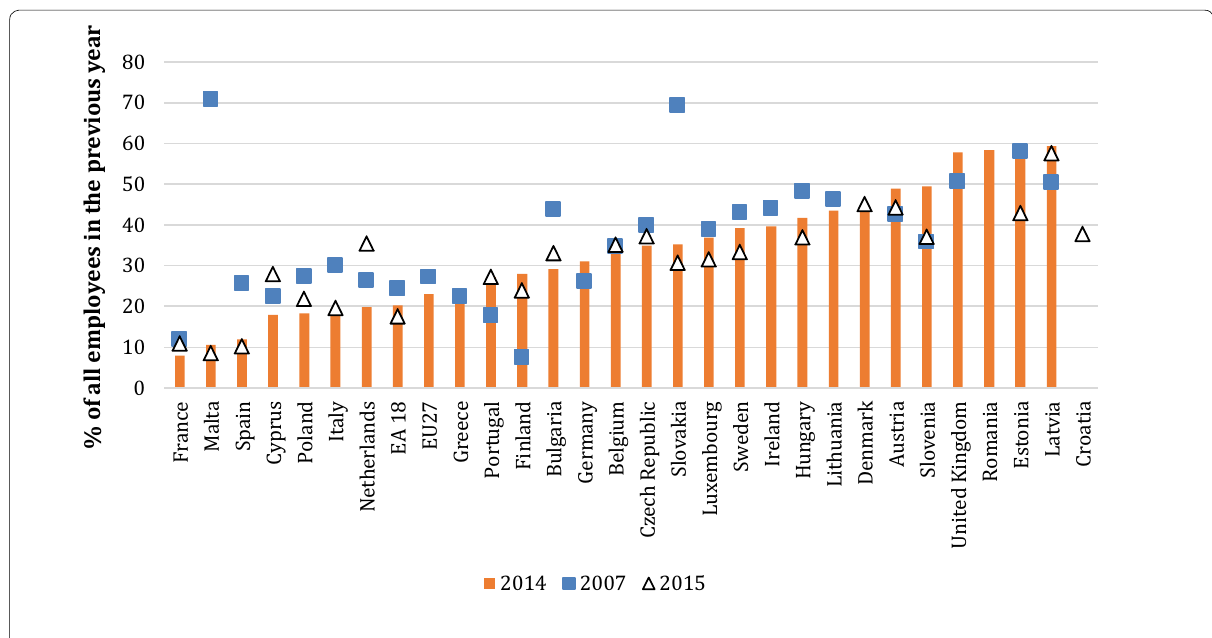
Fig. 3 Year-to-year transition from temporary to permanent contracts. Source : EU-SILC, European Commission (2016, pp. 88). * Data on transitions refers to 2013 for all Member States except for AT, BE, ES and FI for which data on transitions refers to 2014. For these countries, the comparison is made with 2013 while for all others 2012 is used; Data on transitions is not available for IE for 2012 or 2013 or 2014 and for RO for 2013 or